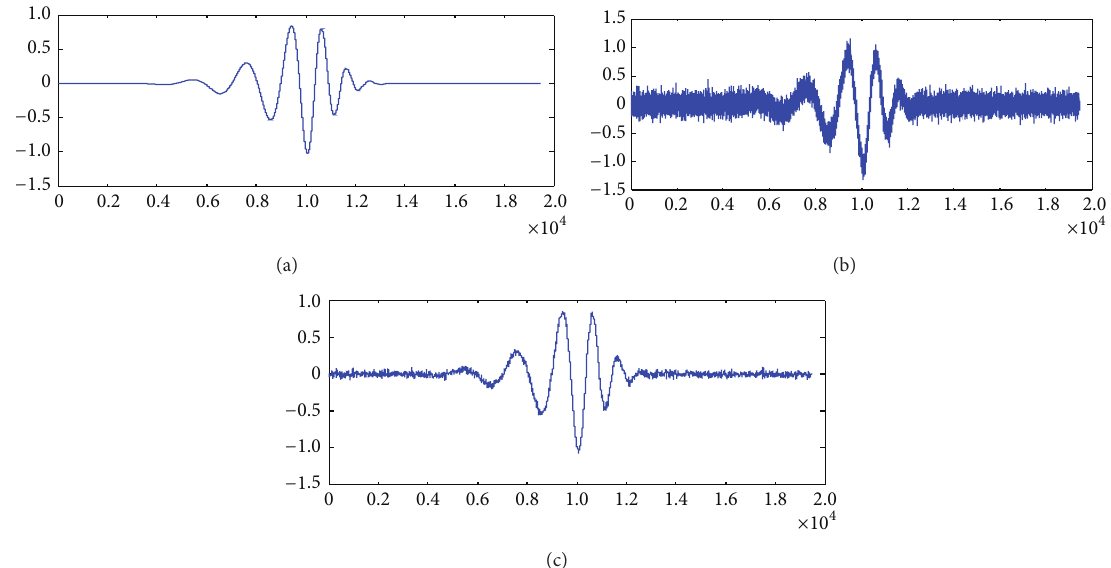
Figure 3: Waveform of (a) Daubechies 10 wavelet, (b) data sequence 𝑋 , and (c) data sequence 𝑌